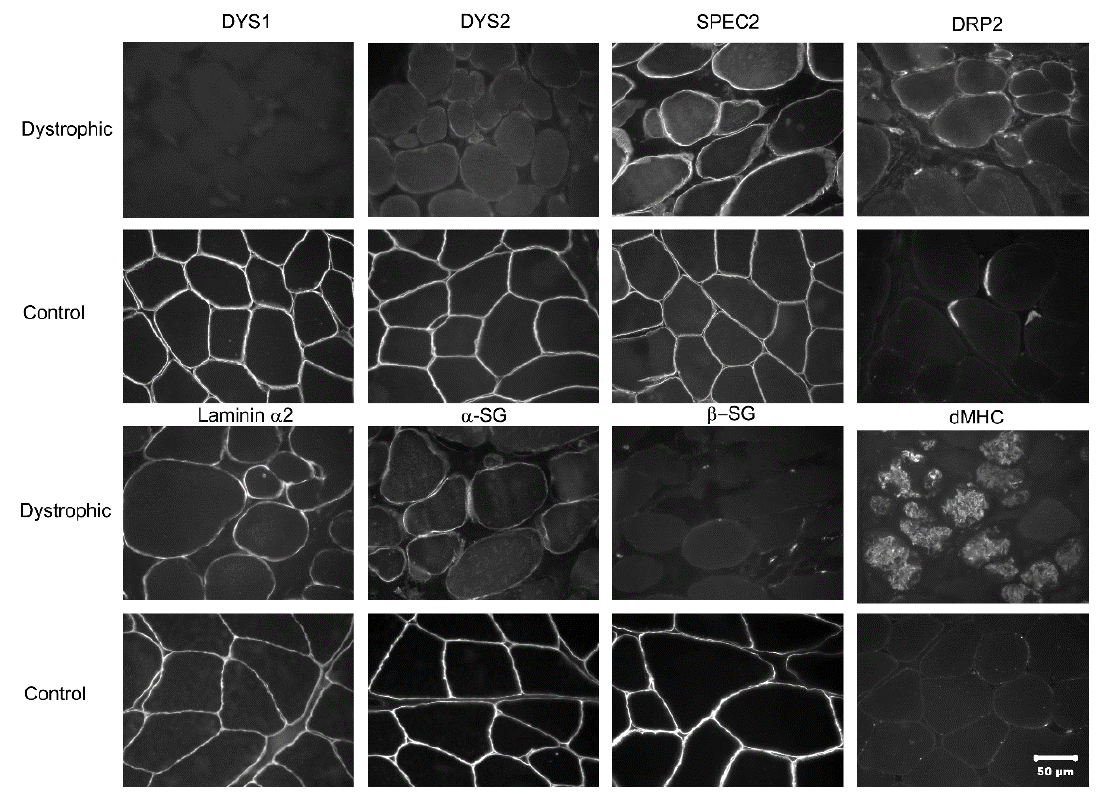
Figure 2. Immunofluorescent staining of dystrophic and control muscle. Immunofluorescent staining of muscle cryosections showing localization of dystrophin and laminin α2. Staining was performed using monoclonal antibodies against the rod-domain (DYS1) and C-terminus (DYS2) of dystrophin, spectrin (SPEC2), utrophin (DRP2), laminin α2, α - and β - sarcoglycan (α - and β -SG, respectively), and developmental myosin heavy chain (dMHC). The magnification bar in the lower right = 50 µm for all images.